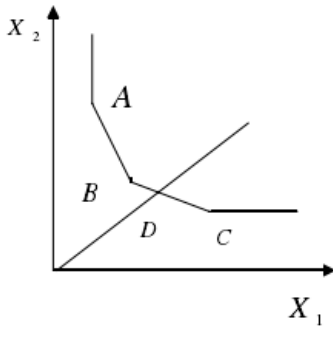
Figure 1. The conceptual graph related to data envelopment analysis (DEA).